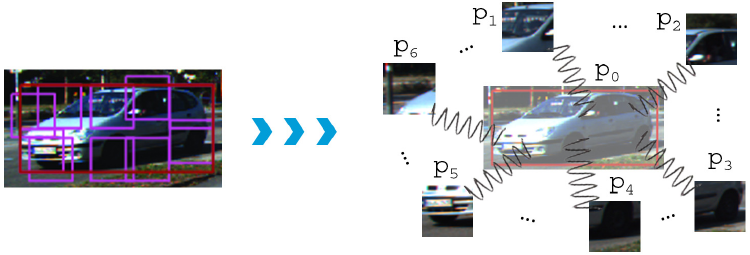
Figure 8. Sample pictorial representation of the spring-like connections between the root p (red box) and the remaining parts ( p